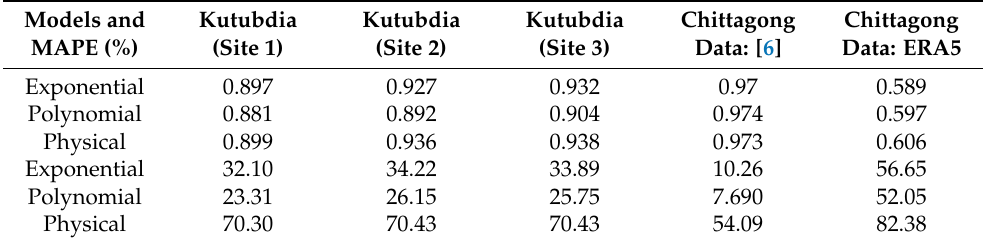
Figure 8. SPPM Forecasts: Polynomial (dashed line), Exponential (solid line), and Physical (thick solid line) compared with observation (open circle) valid for observed data in Kutubdia from [10]. Table 4. SPPM correlation and predictability for four locations in Bangladesh.